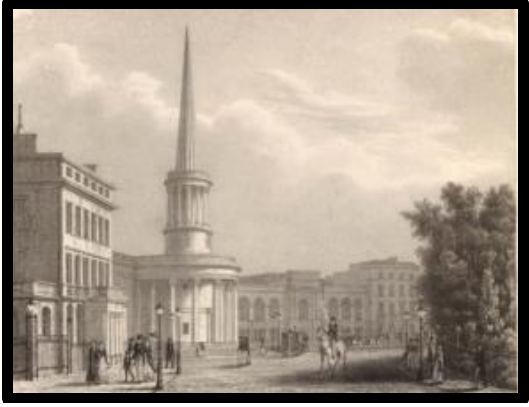
Figure 9: Heath, C (1825) All Souls Church. (URL